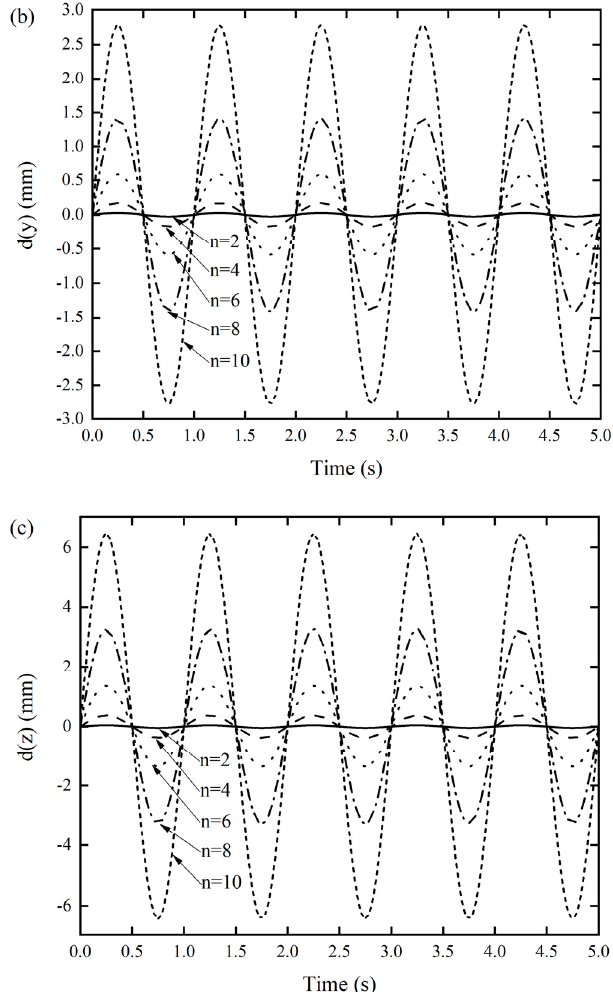
Figure 9. DDR of the Miura tube when the number of arrangements of Miura sheet units varied ( a ) x -displacement of the Miura tube under force along the x -direction, ( b ) y -displacement of the Miura tube under force along the y -direction, and ( c ) z -displacement of the Miura tube under force along the z -direction.